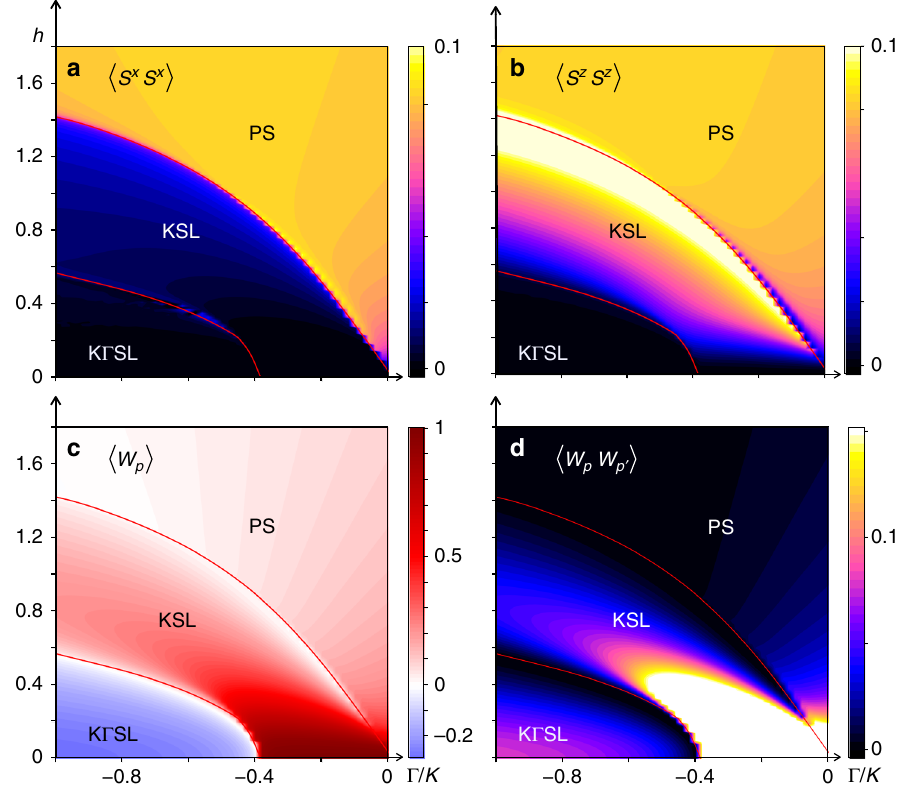
Fig. 6 Underlying phase diagram. Underlying phase diagram with Γ ′ = 0 and θ = 0 in the Γ / K − h plane as calculated with DRMG for N = 200 and OBC. D E and b S z j S z k Spin – spin correlations a S x j S x k